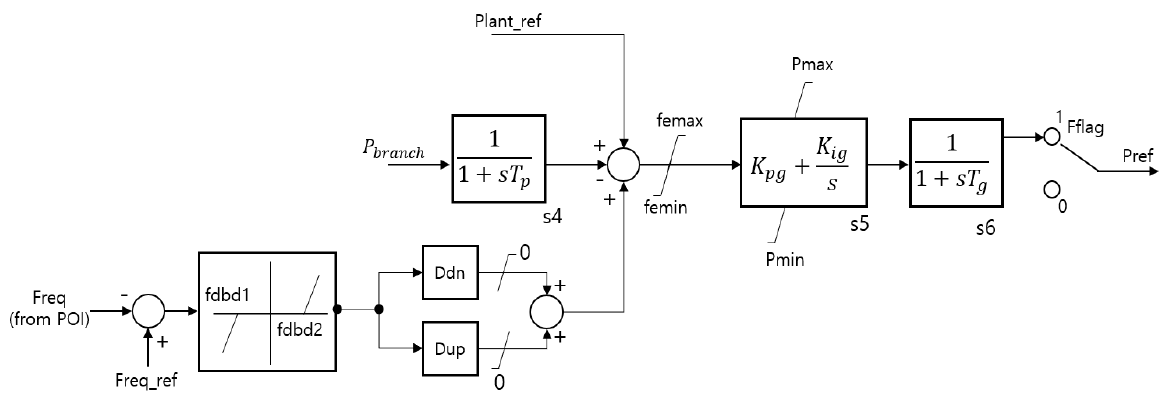
Figure A5. HVDCPLU1 model of PSS/E [15,16]. (3) Energy storage system(s) (ESS). The ESS output of this paper determined the output through the following calcula- tion. The output amount was calculated in consideration of frequency deviation and droop speed.